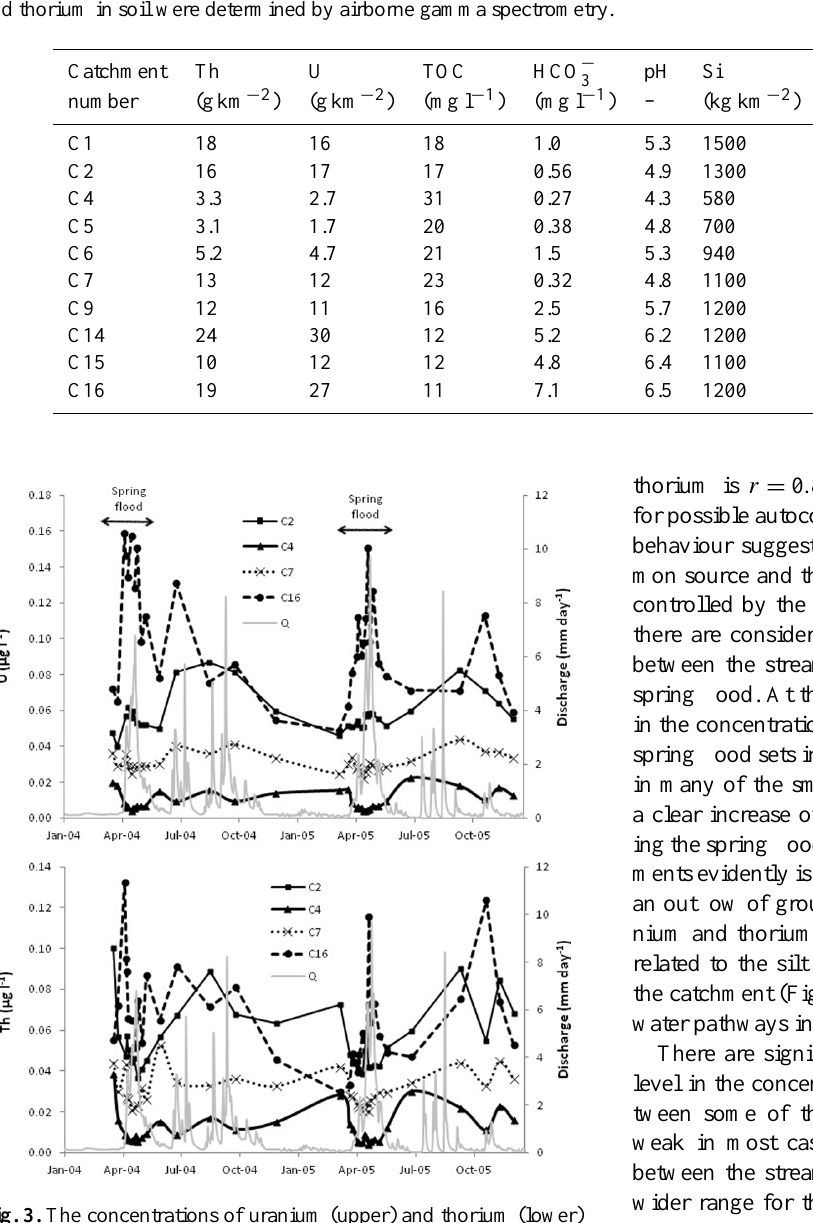
Fig. 3. The concentrations of uranium (upper) and thorium (lower) in four of the investigated streams: C2 (small forested catchment), C4 (mire outlet), C7 (small mixed catchment) and C16 (large mixed catchment). The discharge (Q) is shown in